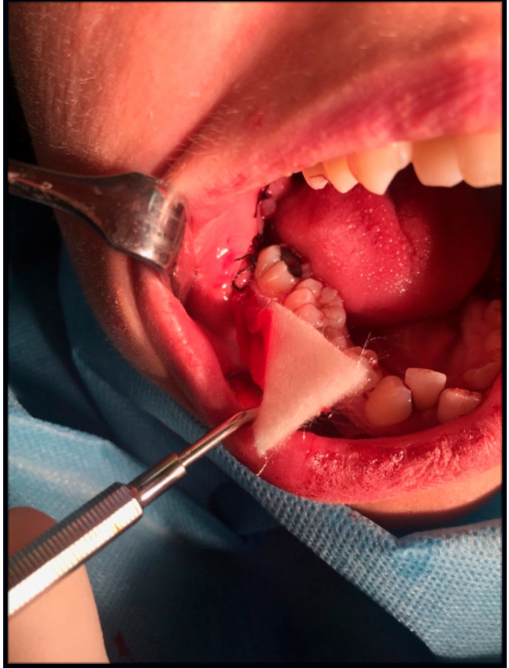
Figure 5. Kaltostat bud in the release incision, in the oral